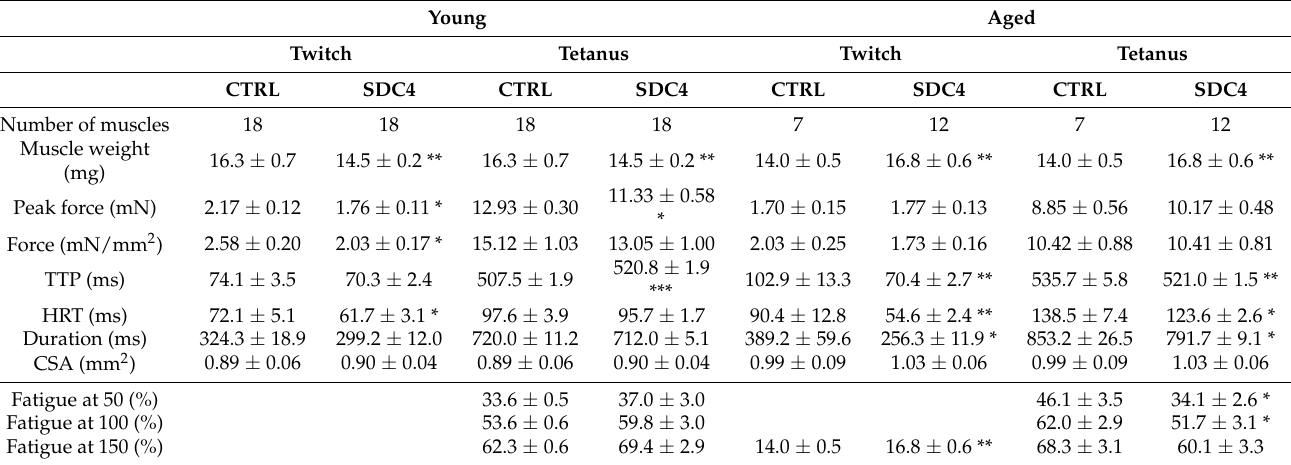
Force parameters in the case of young animals from 9 (5 male and 4 female) and 10 (6 male and 4 female), in case of aged animals from 5 (2 male and 3 female) and 7 (5 male and 2 female) control and Syndecan-4 KD mice, respectively. *, **, and *** show significant difference from control at p < 0.05, p < 0.01, and p < 0.001,